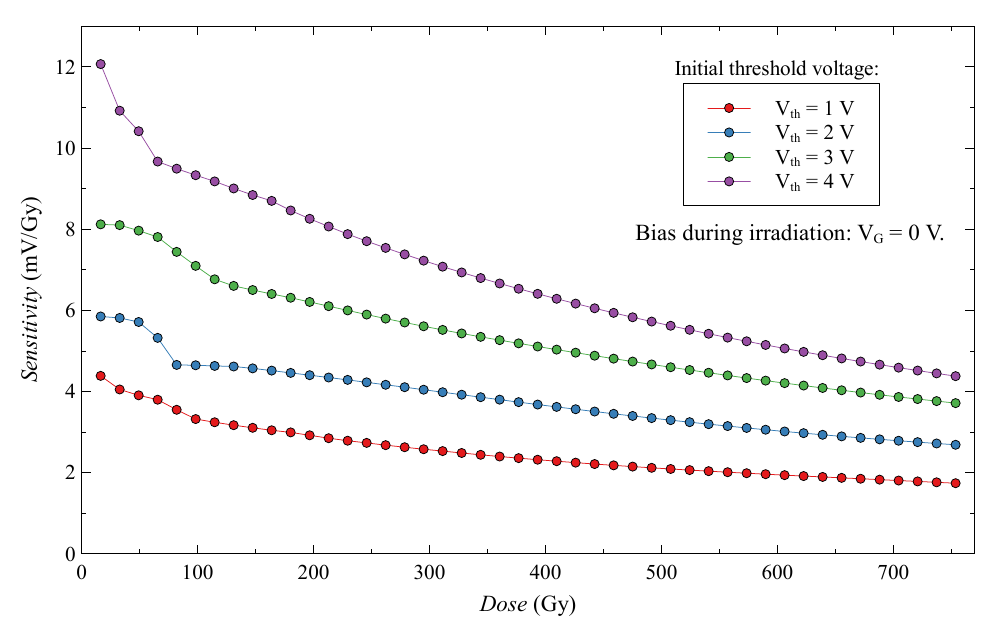
Figure 15. Sensitivity of EPADs with zero bias during